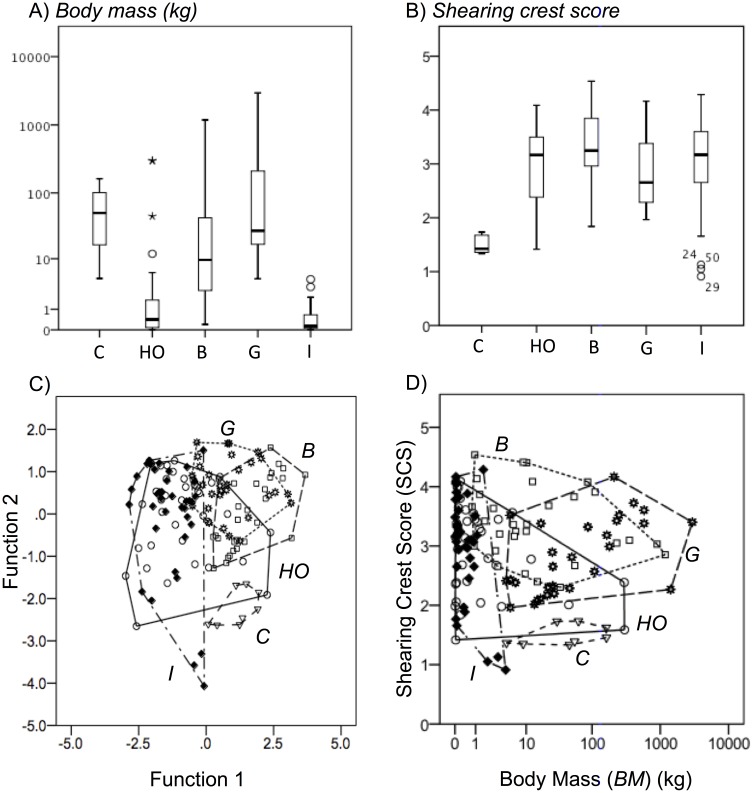
The relative frequencies of body mass and Shearing Crest Score (SCS) within feeding guilds.The distribution of A) body mass (BM) and B) Shearing Crest Score (SCS) among all specimens and feeding guilds is shown. Box plots show the median (center line), interquartile range (boxes), 1.5 times the interquartile range (whiskers), and outlier points. C) Discriminant function analysis using BM and SCS as dependent variables. HO = Hard-Object Feeders, B = Browsers, G = Grazers, I = Insectivores, C = Carnivores. Function 1 (75.2%) and Function 2 (24.8%) are largely synonymous with BM/Ps and SCS, respectively. Wilks’ Lambda = 0.686, Chi-Square = 51.76, p<0.001. The discriminant function coefficients are BM
−0.157/0.989, SCS
0.994/0.116, Ps
0.845/−0.416, Pl
0.071/−0.166. D) Bivariate plot, BM vs. SCS, showing polygonal dietary morphospaces. Hulls delineate dietary groups.